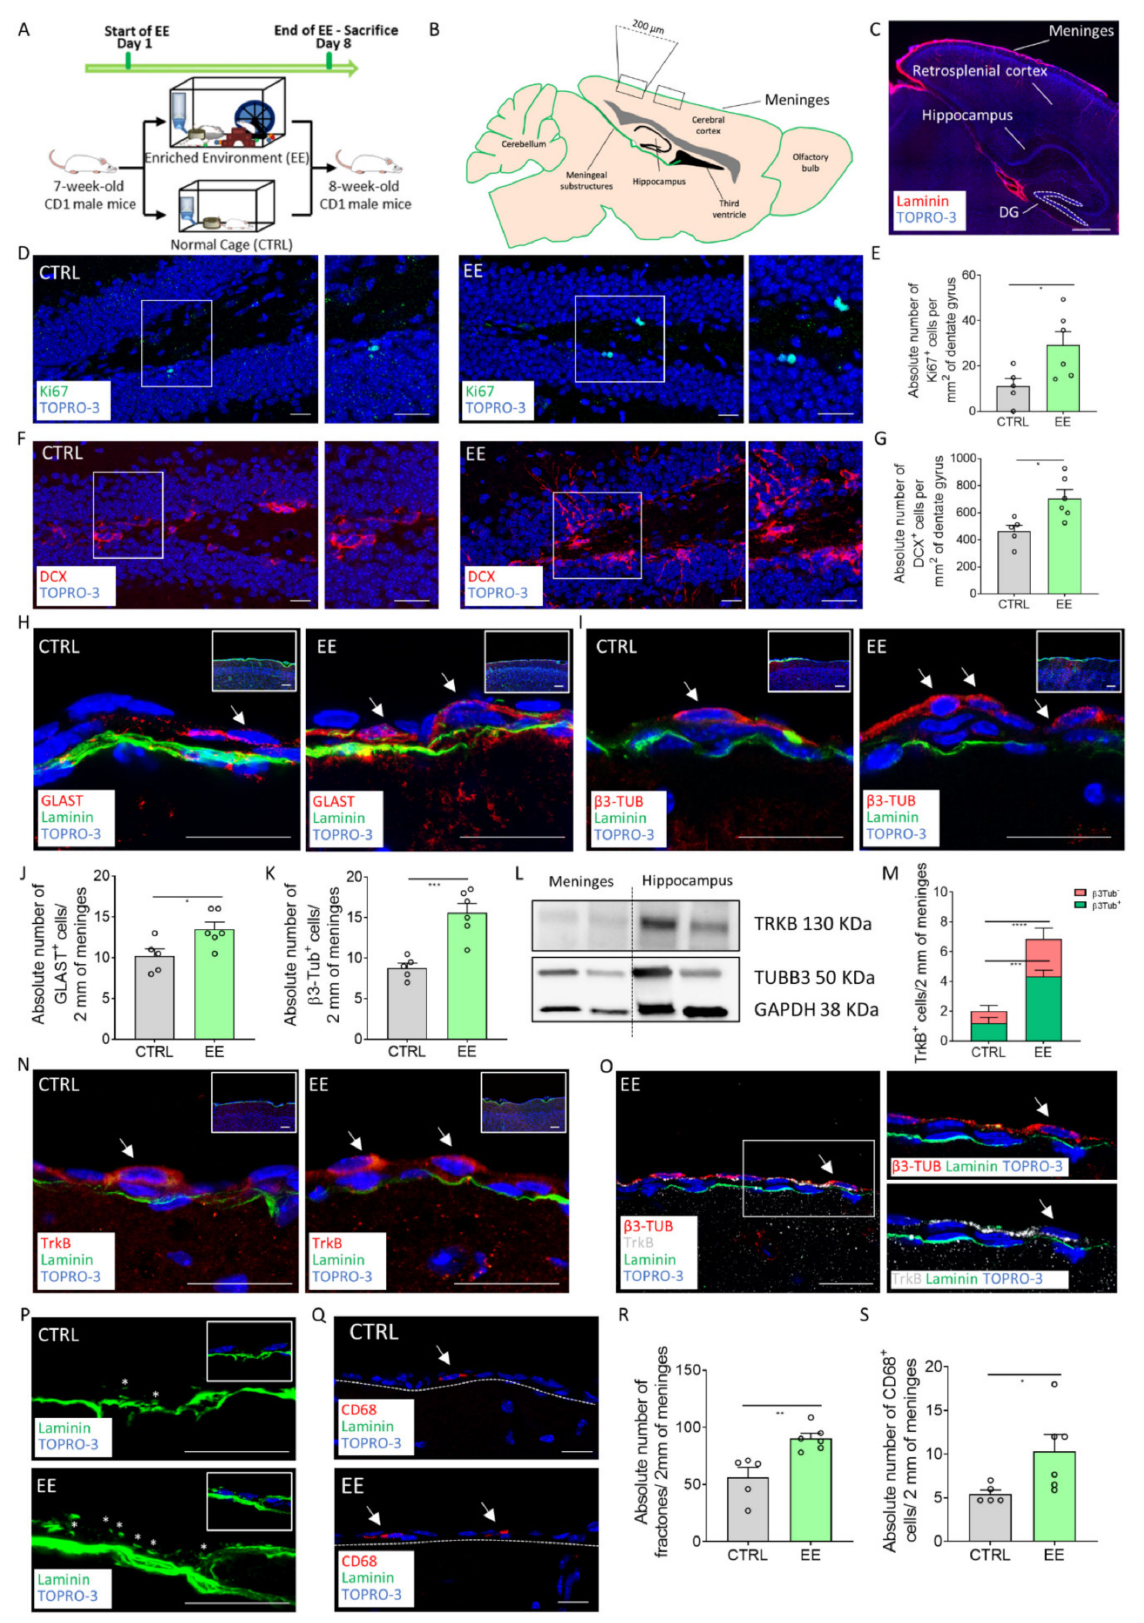
Figure 1. The meningeal niche is responsive to enriched environment exposure. ( A ) Schematic representation of the experimental design used for EE exposure. ( B ) Scheme depicting the sagittal section of the mouse brain, highlighting the specific regions where brain external meninges were analyzed. ( C ) Sagittal brain section of CD1 mice with laminin